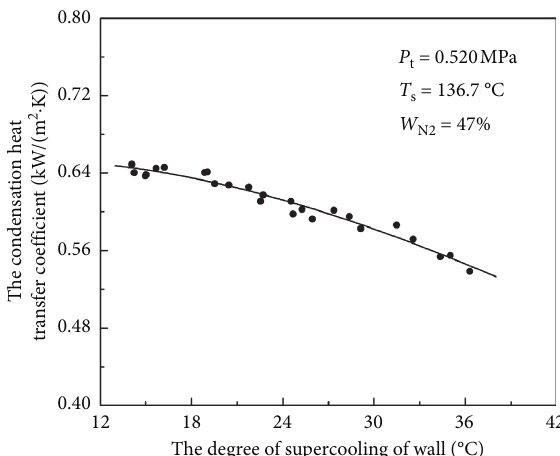
Figure 7: The effect of degree of supercooling of the wall on steam